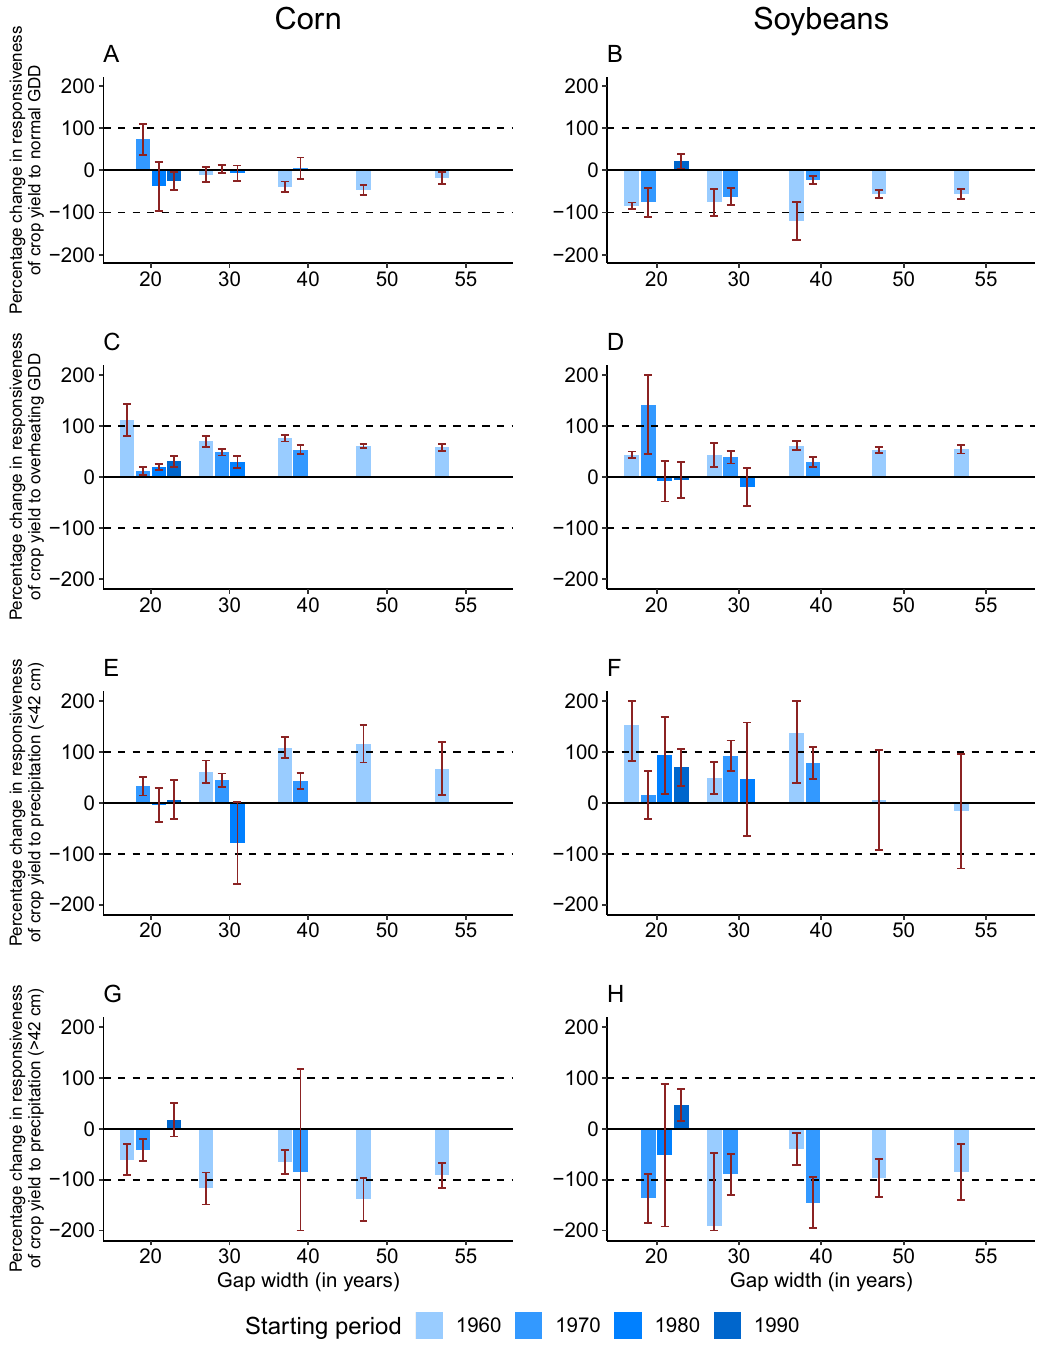
Figure 2. Percentage changes in responsiveness of crop yields to climate. Notes : This figure shows the percentage change in responsiveness of crop yield to climatic variables. We select two five-year periods with five different gap widths (i.e., 20-year, 30-year, 40-year, 50-year, and 55-year) and four different starting periods centered in 1960, 1970, 1980, and 1990 (in total 11 scenarios). For instance, a scenario with starting year as 1960 and 20-year gap width utilizes data over periods 1958–1962 and 1978–1982 to conduct the flexible long differences approach to estimate the climatic impact on yield over the two periods. The length of a bar represents the percentage change in responsiveness of crop yield to the corresponding climate variable over the two periods. In the context of Fig. 1, it is the difference between slope of Curve 1 at point A and slope of Curve 2 at point B (for computation details see ‘Methods’). A bar with a positive value indicates an enlargement of a positive responsiveness or a shrinkage in a negative responsiveness over the two periods, whereas a bar with a negative value indicates the opposite. The whiskers are 95% confidence intervals of the estimates. Some bars are missing because the estimated responsiveness to the corresponding climate variable in the earlier period is statistically insignificant, and thus, the percentage change is undefined. Graphs A, C, E, and G are for corn yield and Graphs B, D, F, and H are for soybean